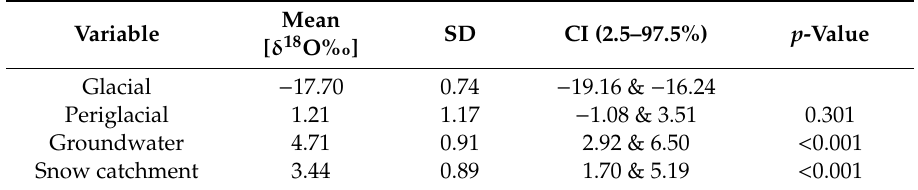
Table 1. Mean, standard deviation (SD) and confidence interval δ 18 O composition for water sources in comparison with the Glacial system. Akaike weight w = 1; R 2 =